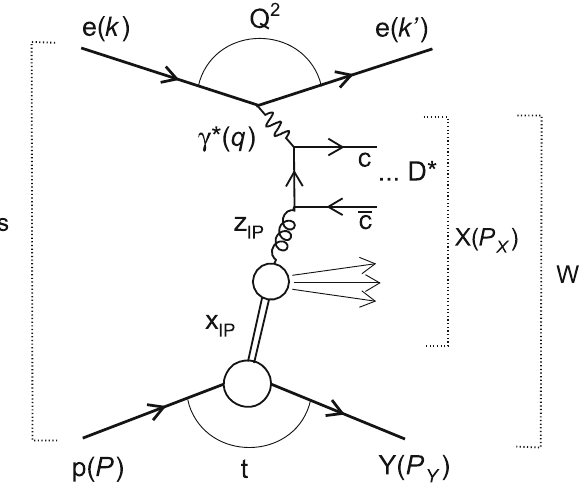
Fig. 1 Theleadingorderdiagramforopencharmproductionindiffrac- tive DIS at HERA in the picture of collinear and proton vertex factori-